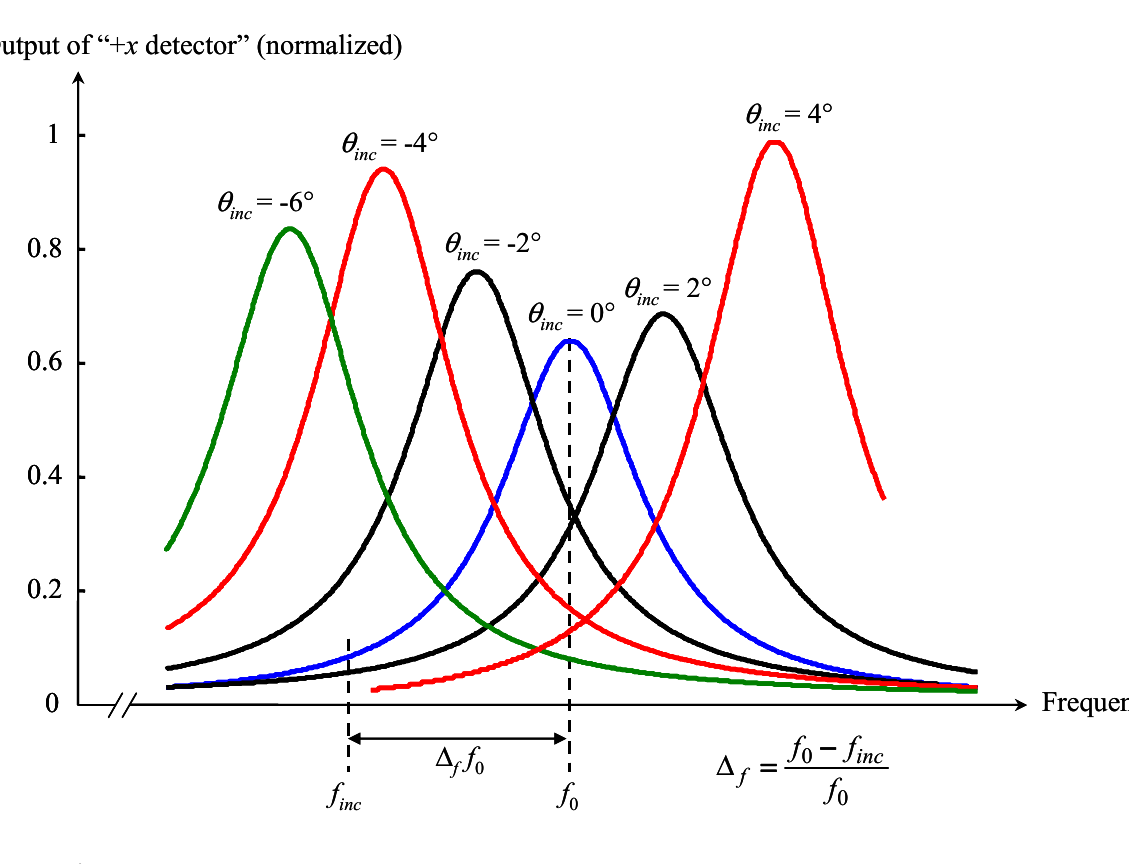
Figure 2. Illustration of the angle detector’s